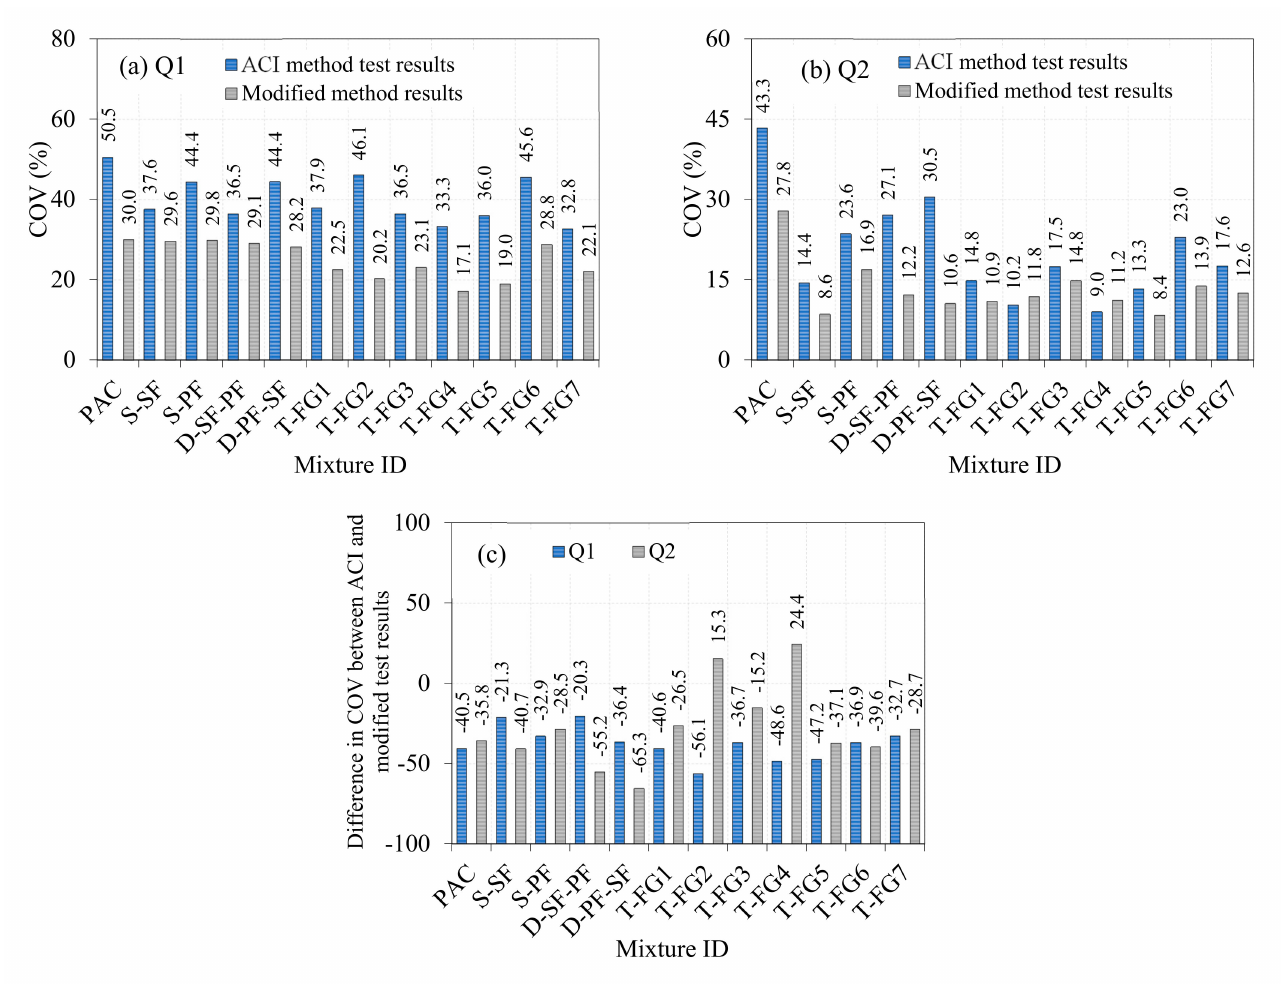
Figure 16. COV results of the ACI and the modified technique impact tests are compared ( a ) Q1,